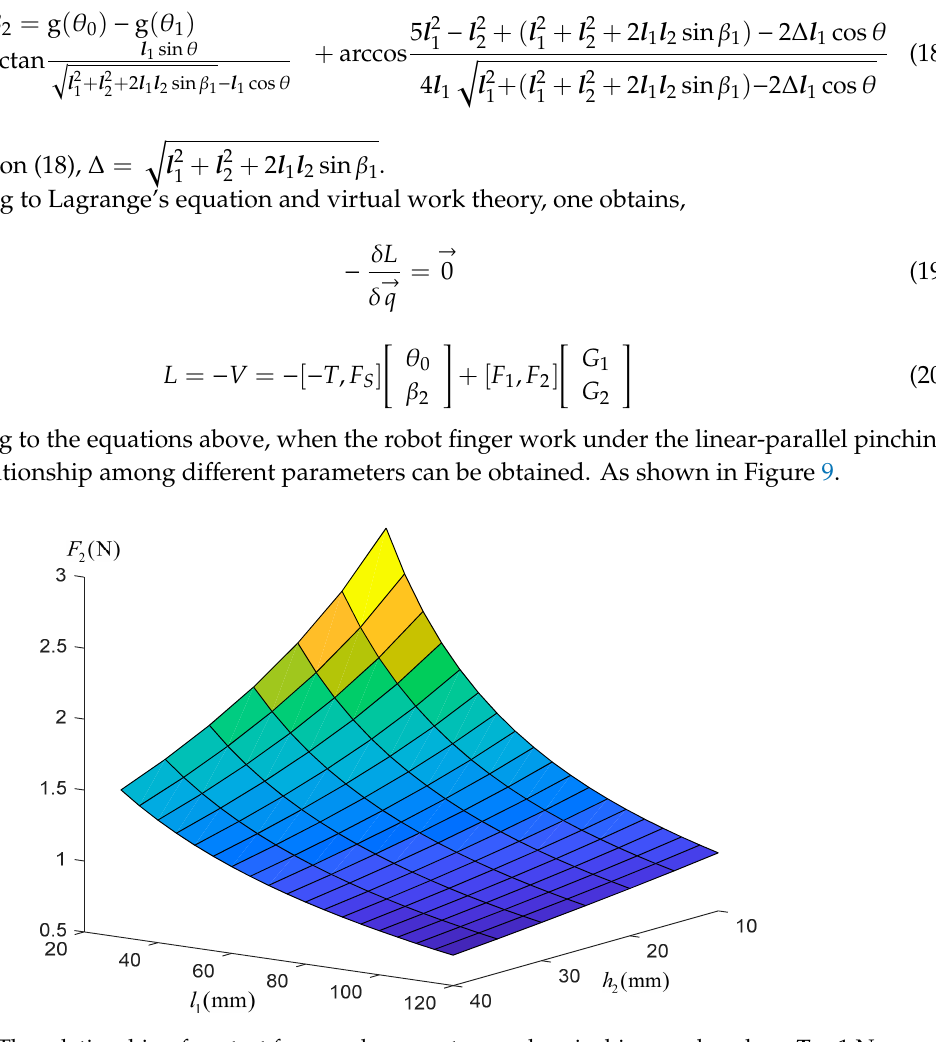
Figure 9. The relationship of contact force and parameters under pinching mode, where T = 1 Nm, F 1 = 0, β 2 = constant, θ 3 = θ 2 .